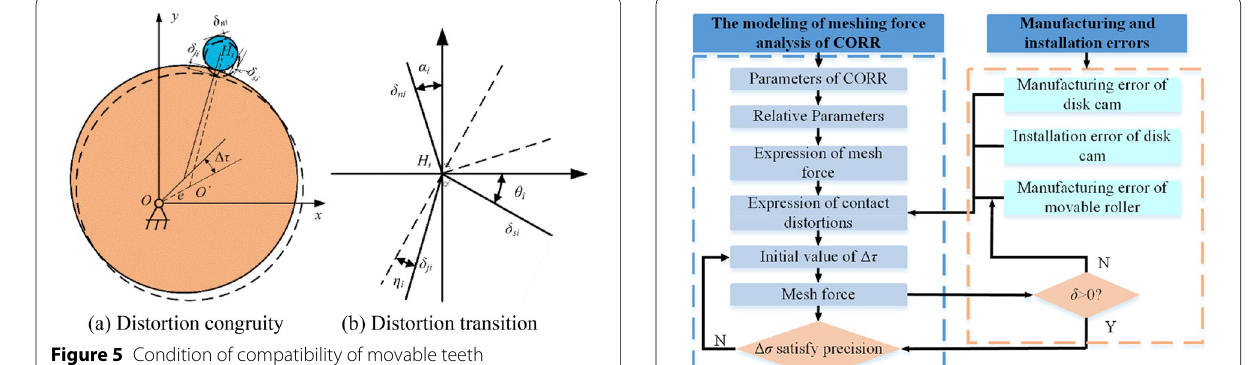
Figure 5 Condition of compatibility of movable teeth